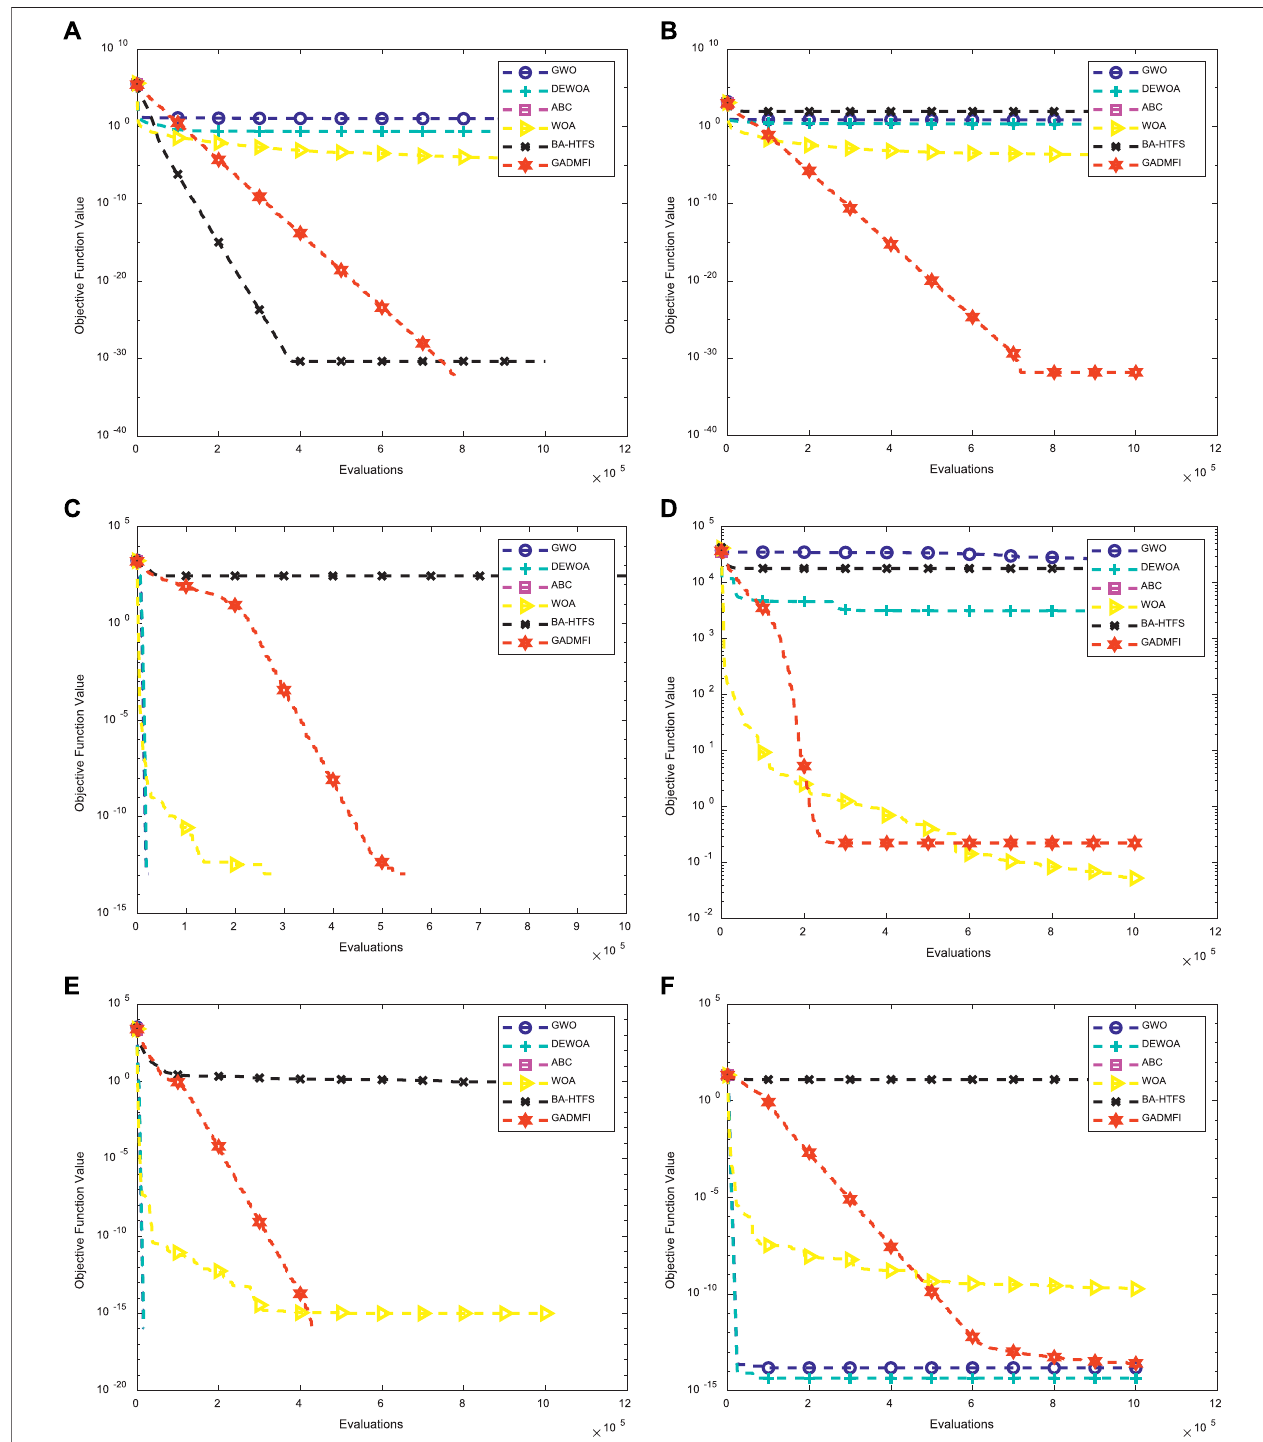
FIGURE3| Evolutioncurvesofsixfunctionsof100dimensionsareshown.Ascanbeseen,theconvergencecurveoftheGADMFIshowssuperiorexplorationand exploitation abilities. (A) The curve presents a straight line, which shows that when dealing with unimodal problems, the proposed DMFI has the potential to explore a promising area. (B – F) With multiple local minima, it stays at approximately constant speed until it converges, which again con fi rms the role of DMFI.